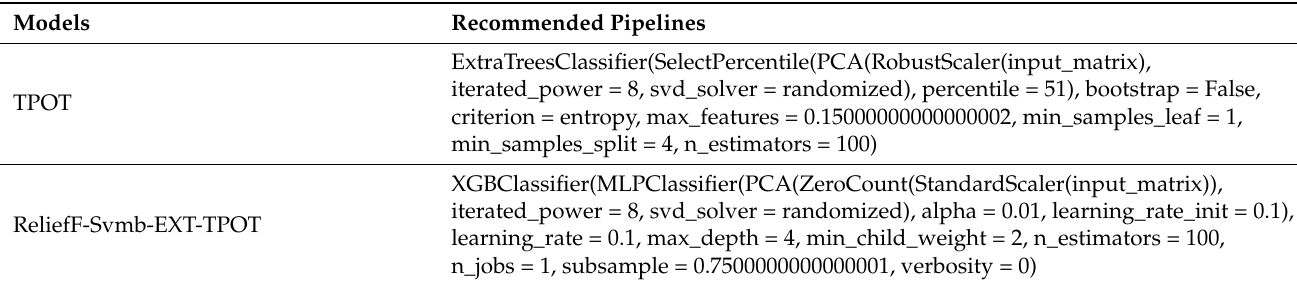
Table A1. Recommended pipelines of TPOT models from the proposed system, full multi-date image and single-date